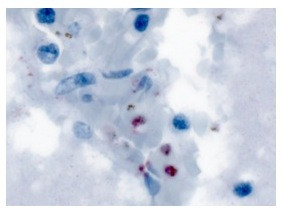
Plasmodium-specific anti-aldolase immunohistochemistry stained sections from the brain. Parasites appear red.